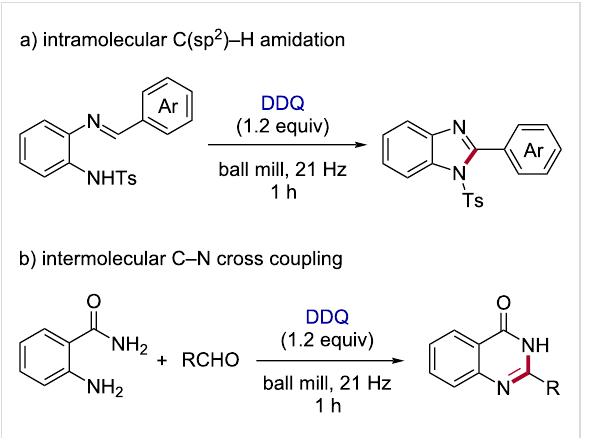
Figure 1: Our work on mechanochemical C–N coupling reactions using DDQ. The newly formed C–N bonds are shown as red lines for clarity. a) The intramolecular C(sp 2 )-H amidation leading to 1,2-disub- stituted benzimidazoles. b) One-pot coupling to synthesize substituted quinazolin-4(3 H )-ones.